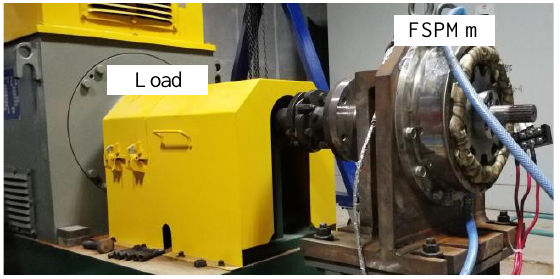
Figure 17. Experiment